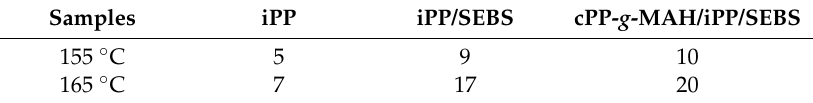
Table 4. Thermal elongation of different samples at 155 and 165 °C (%).